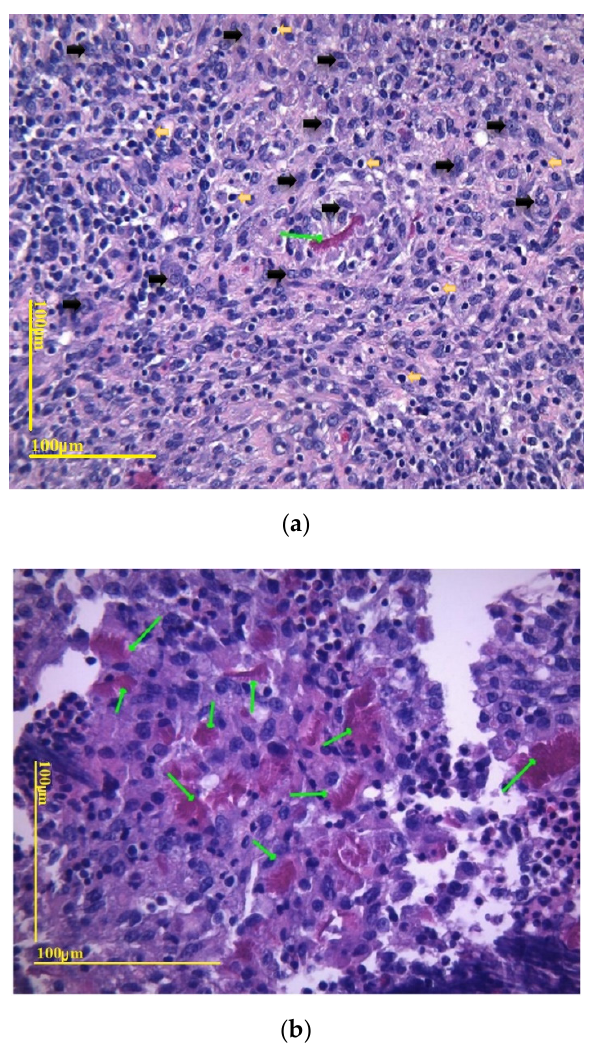
Figure 5. ( a ) GelMA section, ×20 magnification at 100 microns. Green arrows mark GelMA-biomaterial surrounded by histiocytes (black arrows) and lymphocytes (yellow arrows) random inflammatory cells; ( b ) GelMA section, ×40 magnification at 100 microns. Green arrows mark GelMA.